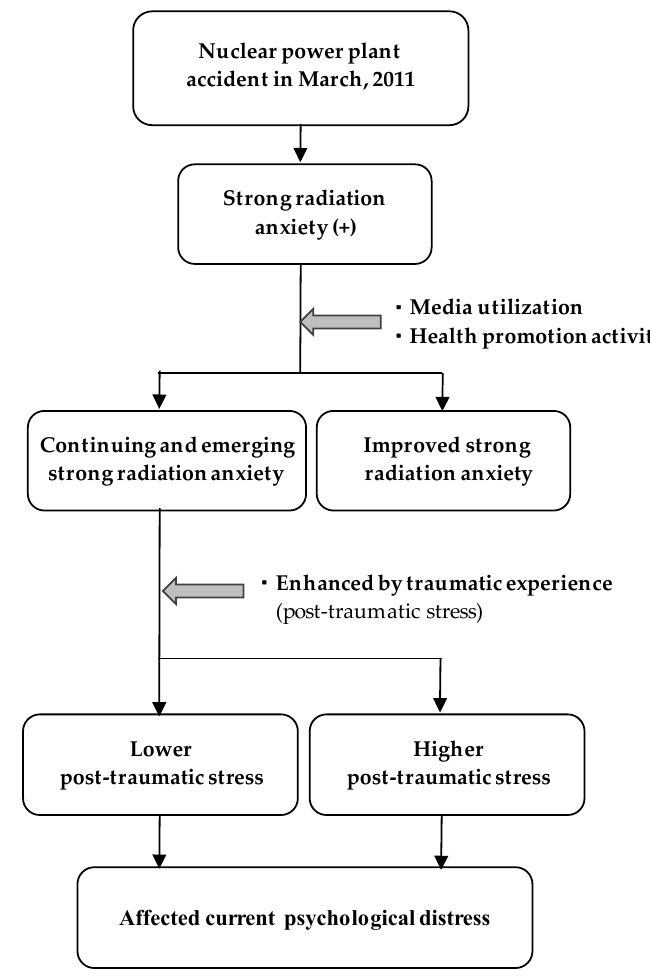
Figure 2. Conceptual model of the analysis in present study.